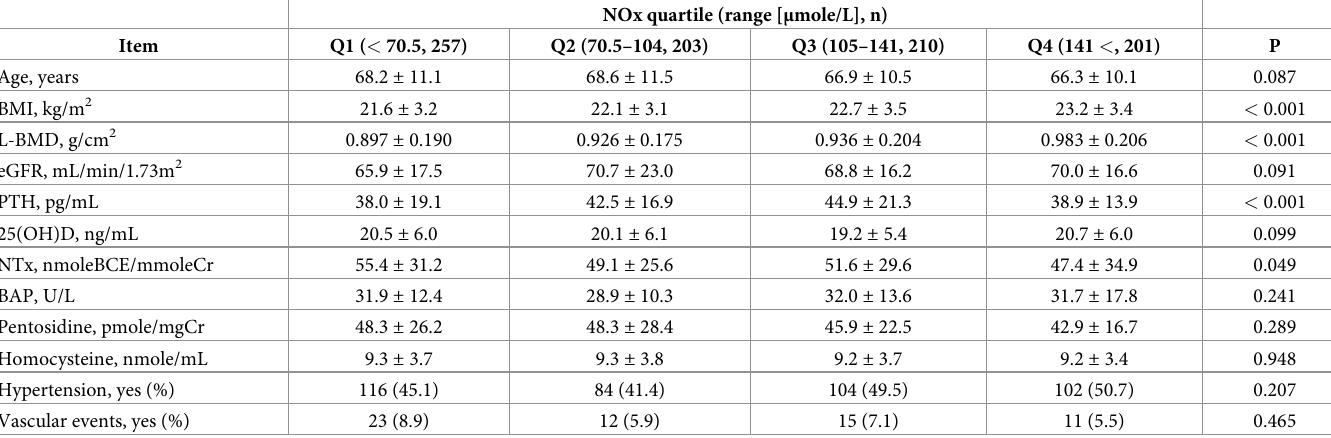
Table 3. Quartile analysis of NOx for bone parameters and co-morbidities.